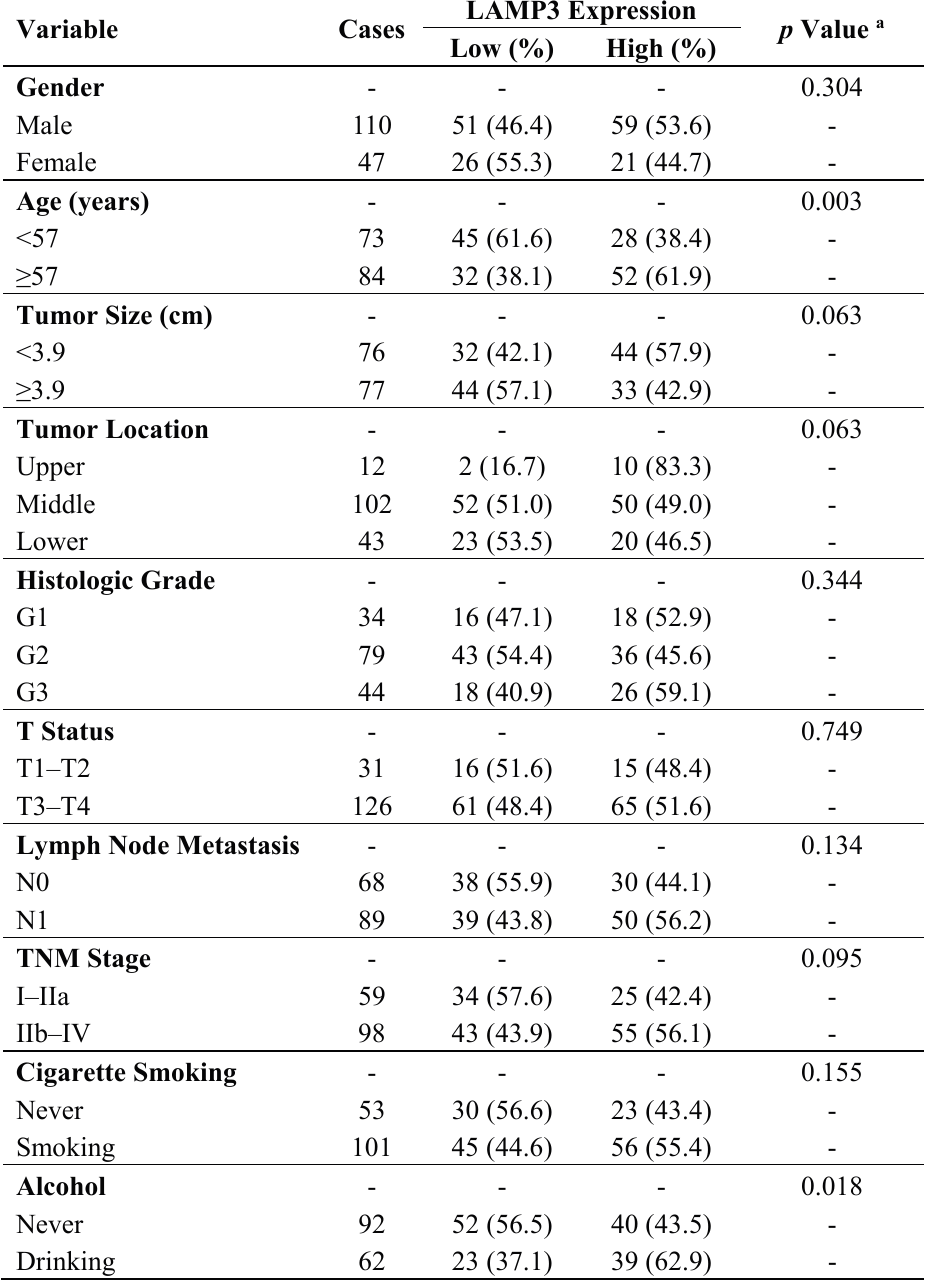
Table 1. LAMP3 expression and clinicopathological characteristics in ESCC.